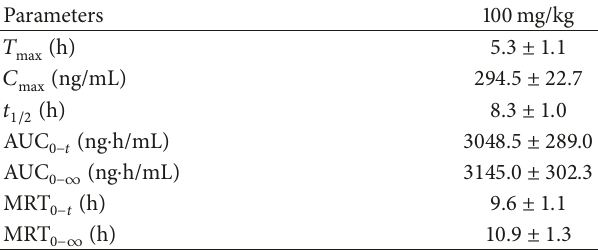
Table 2: Pharmacokinetic parameters of icaritin in rat plasma after oral